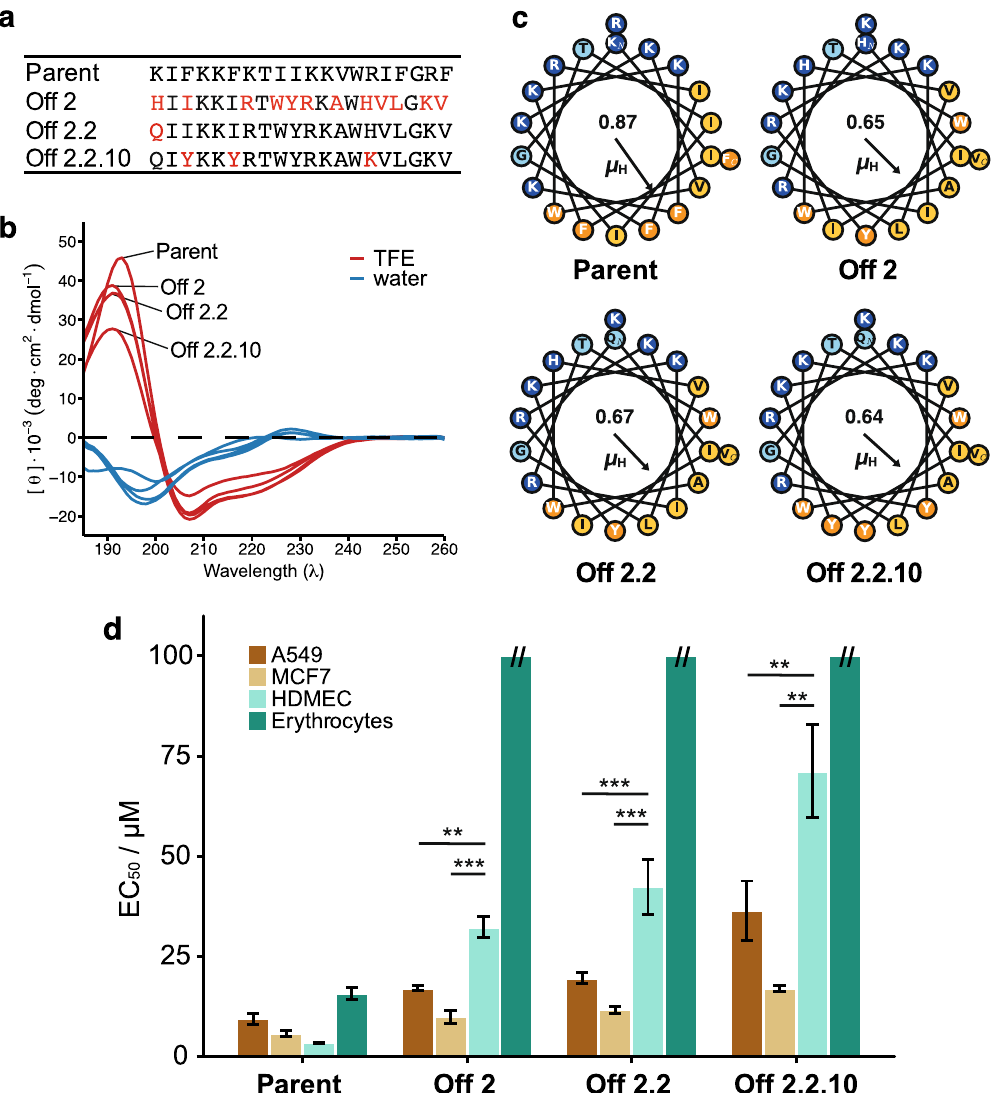
Figure 3. Characterization of the parent peptides and the most selective offspring peptides from three subsequent SME generations. ( a ) Amino acid sequences; red residues denote sequence changes from the respective parent sequence. ( b ) Circular dichroism spectra in water (blue) and a mixture of 50% v/v TFE:water. ( c ) Helical wheel plots with hydrophobic moment direction and magnitude ( µ H ). Residue coloring: polar residues in light blue, positively ionizable residues in dark blue, hydrophobic residues in yellow, and aromatic residues in orange. ( d ) Peptide activity towards the A549 and MCF7 cancer cell lines (EC 50 ), the noncancer HDMEC primary cells (EC 50 ), and the human erythrocytes (HC 50 ). The error bars represent the standard deviation of three independent measurements. ** p -value < 0.01, *** p -value < 0.001 of the mean differences (Welch